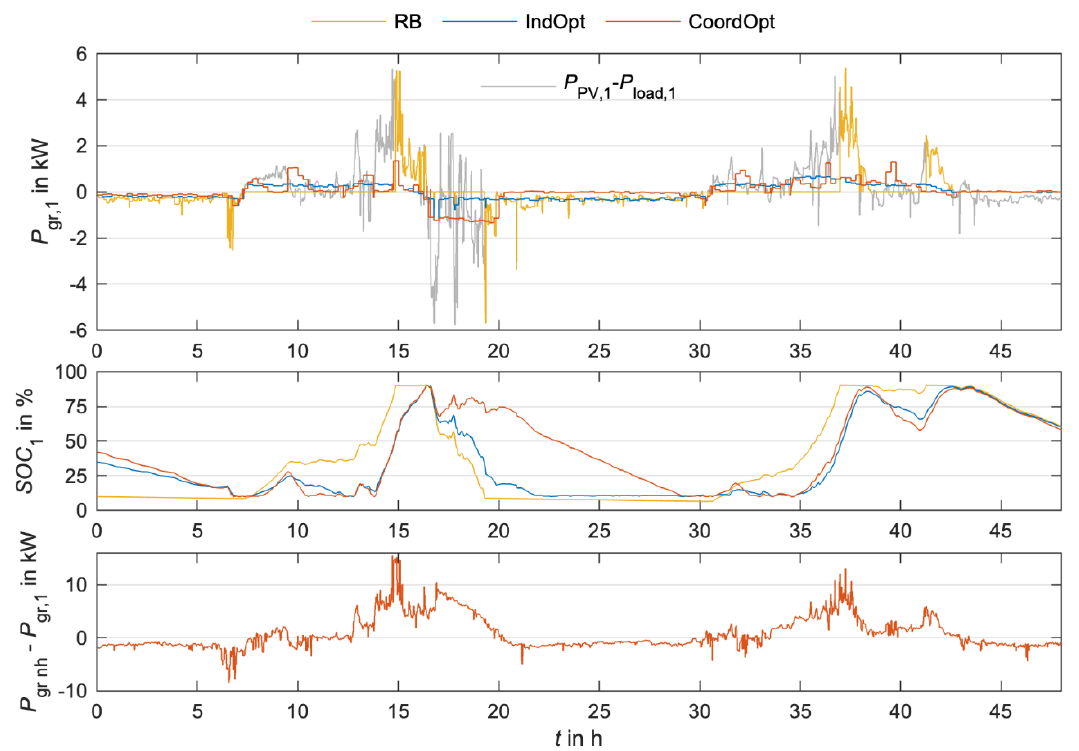
Figure 9. Grid power profiles and SOC trajectories of household H 1 for two exemplary days in the summer.